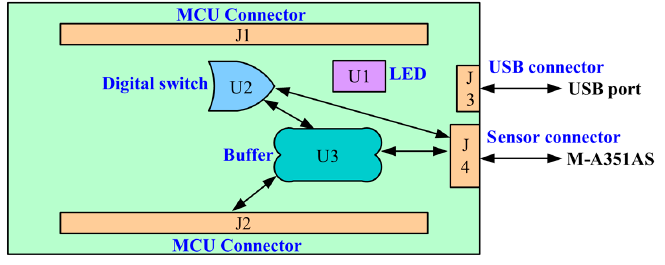
Figure 5. Design concept of high-sensitivity sensor board.